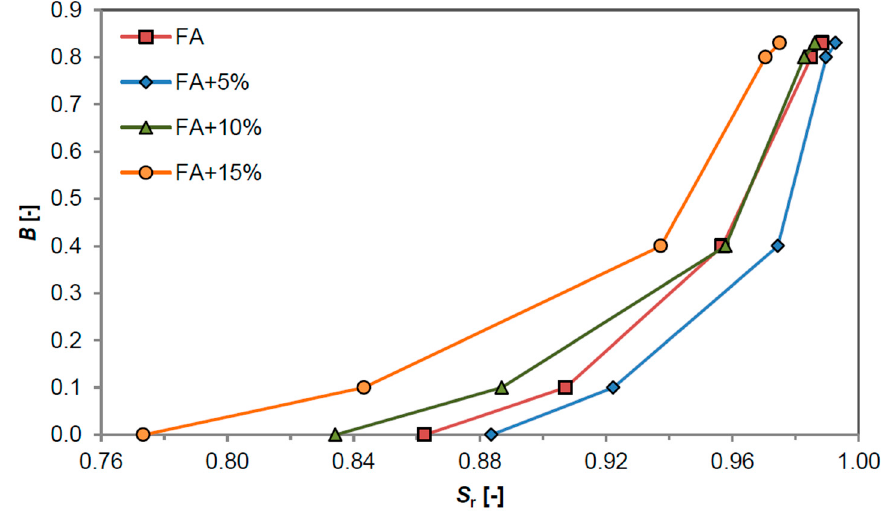
Figure 5. The relation between B parameter and degree of saturation S r for tested fly ash and fly ash-bentonite mixture.